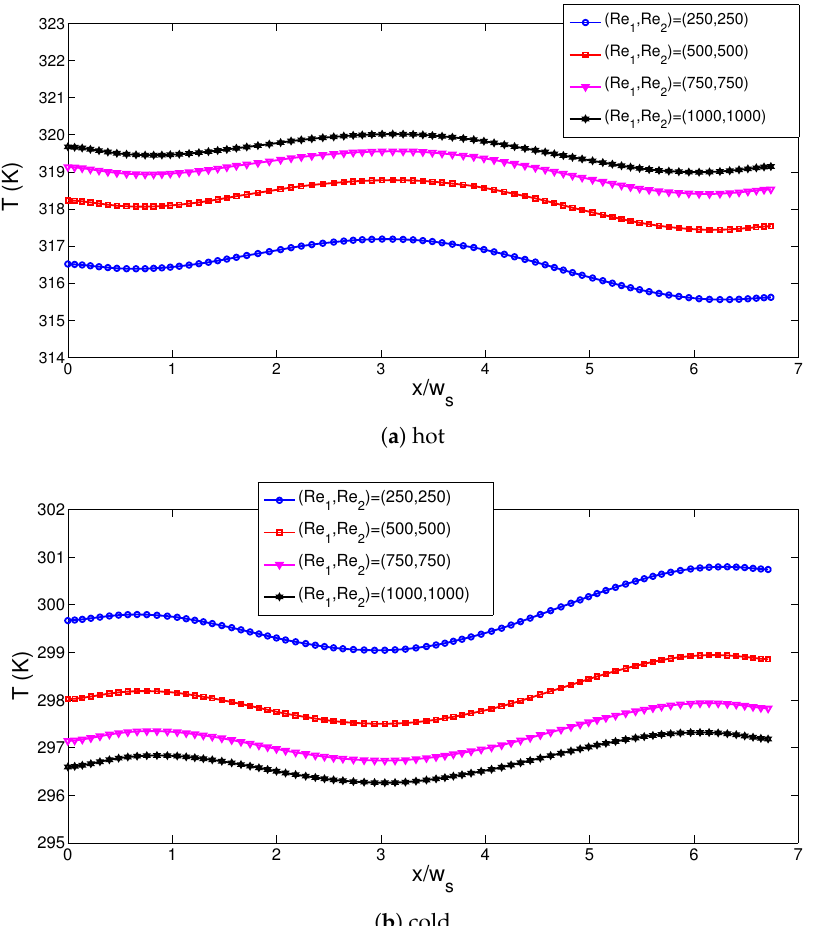
Figure 7. Effects of different jet stream Reynolds number combinations on the distribution of hot ( a ) and cold ( b ) interface temperatures (mid-axis) ((r 1 , r 2 ) = (1, 1), z h = 3w s , φ =